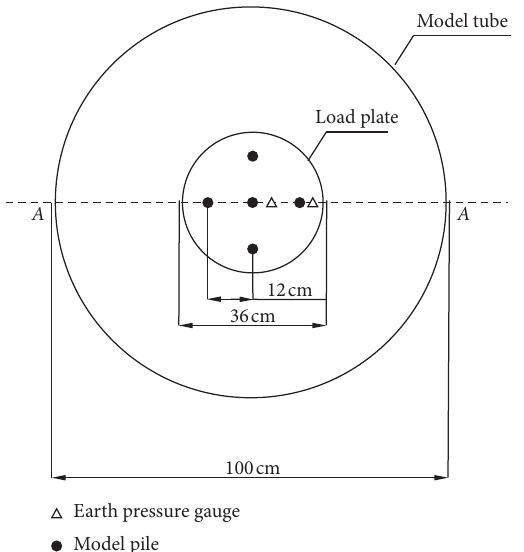
Figure 3: Laboratory model test arrangement of the group pile composite foundation.